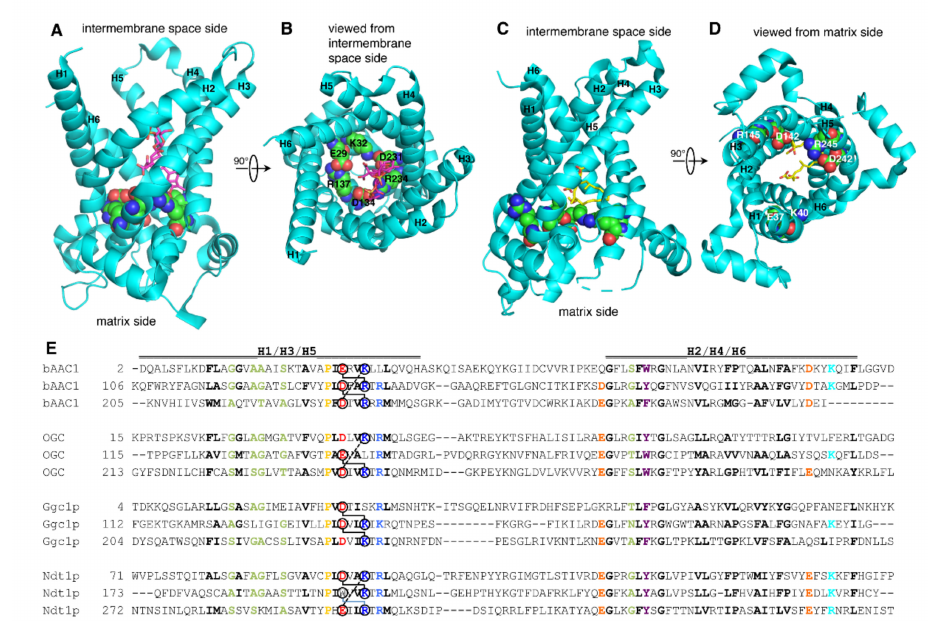
Figure 1. Structure and sequence analysis of the matrix charged network of MCs. Bovine AAC1 structure (cyan) with carboxyatractyloside (sticks with carbons in magenta) and the charged residues of the PX[DE]XX[KR] motifs (in spheres) viewed from the membrane plane ( A ) and the intermem- brane space side ( B ). TtAAC structure (cyan) with bongkrekic acid (sticks with carbons in yellow) and the charged residues of the PX[DE]XX[KR] motifs (in spheres) viewed from the membrane plane ( C ) and the matrix side ( D ). Sequence comparison of the three mitochondrial carrier domain repeats of bAAC1, OGC, Ggc1p, and Ndt1p ( E ). The following sequence features are indicated: the position of the transmembrane helices H1–H6 (a line above the sequences), and the residues that are conserved (bold); hydrophobic (black); small (green); proline (yellow); negatively charged (red) and positively charged (blue) of the PX[DE]XX[KR] motifs; aromatic (purple); negatively charged (orange) and positively charged (cyan) residues of the even-numbered α -helices. The salt bridge charged pairs of the PX[DE]XX[KR] motifs are indicated by